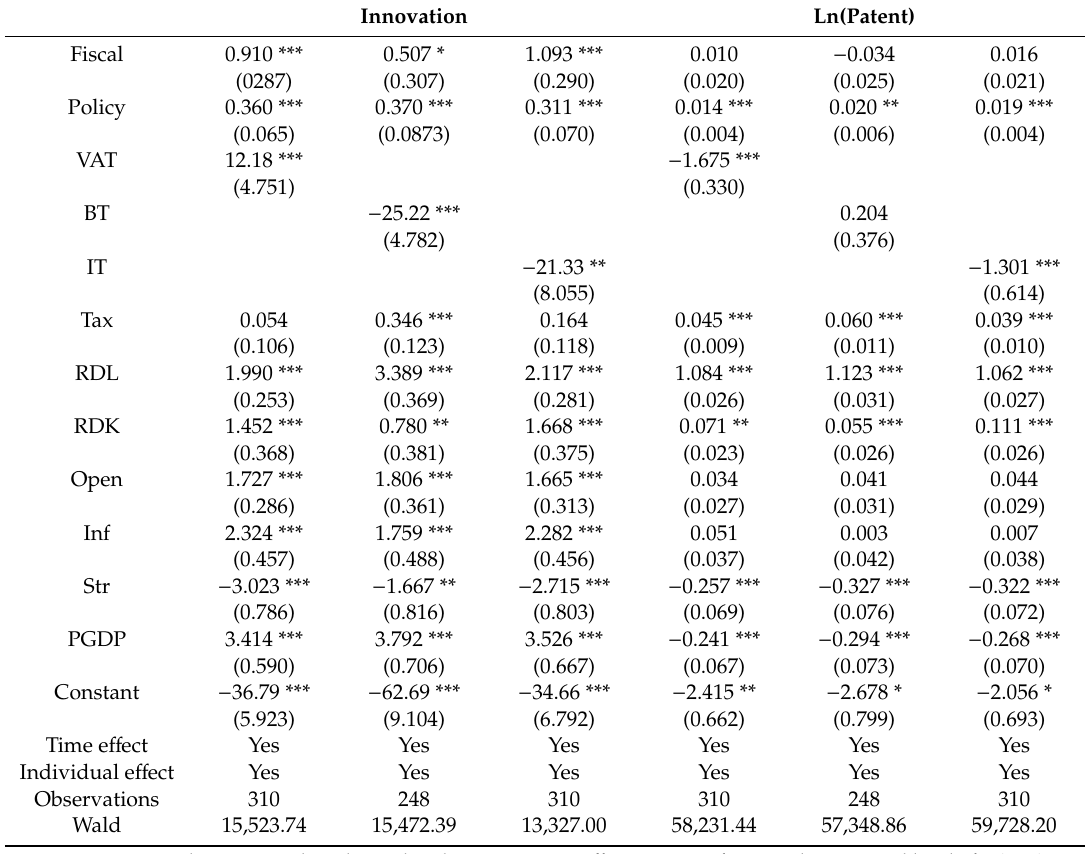
Table 4. The results of empirical